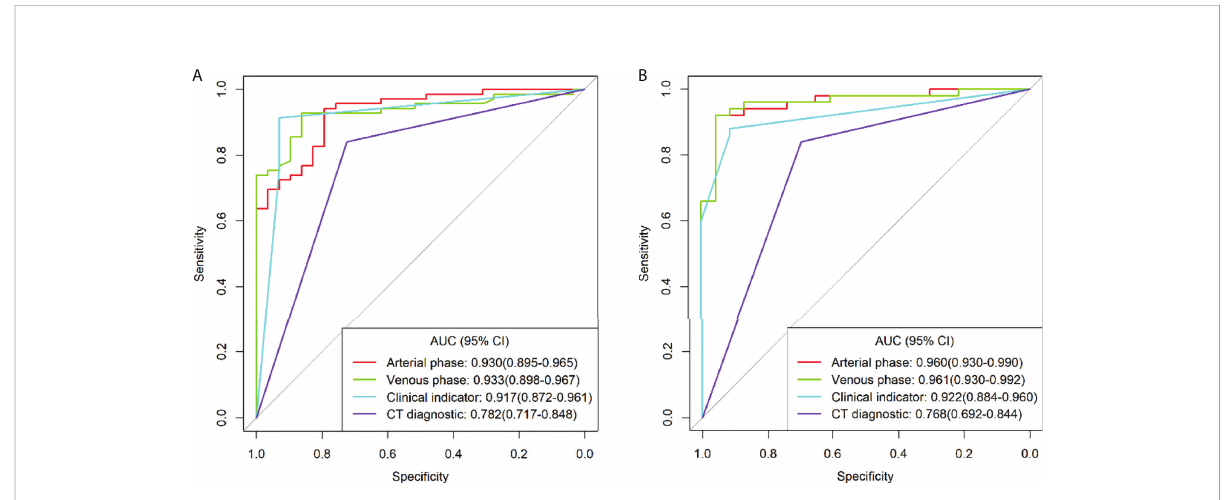
FIGURE 3 Receiver operating characteristics (ROC) curve analysis for different models in the training group (A) and validation group (B) .